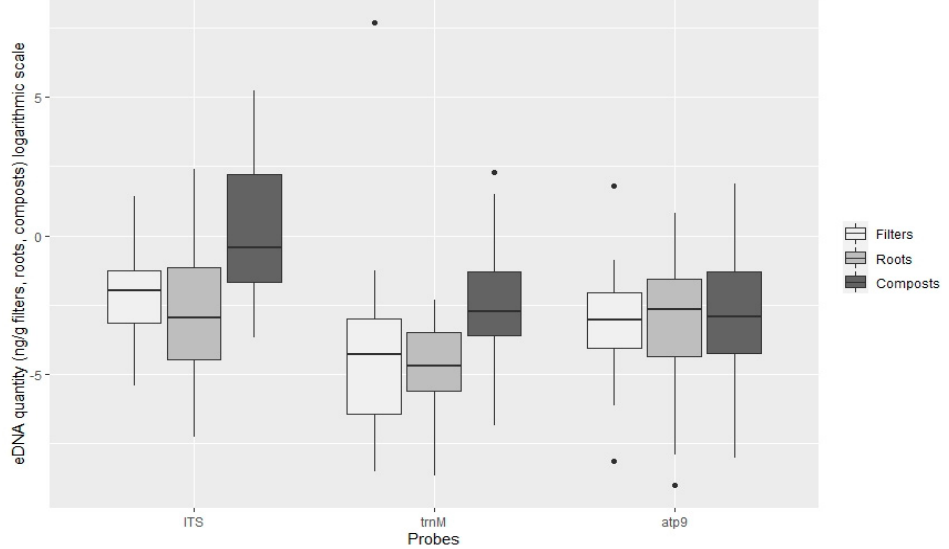
Figure 4. Quantification of oomycete eDNA (ng g − 1 , logarithmic scale) by TaqMan probe on filters, roots and plant composts. Boxplots indicate the 25th percentile (Q1, lower boundary), median (black line) and 75th percentile (Q3, upper boundary). Upper and lower whiskers indicate 10th and 90th percentiles. Dots above and below the whiskers represent outliers.